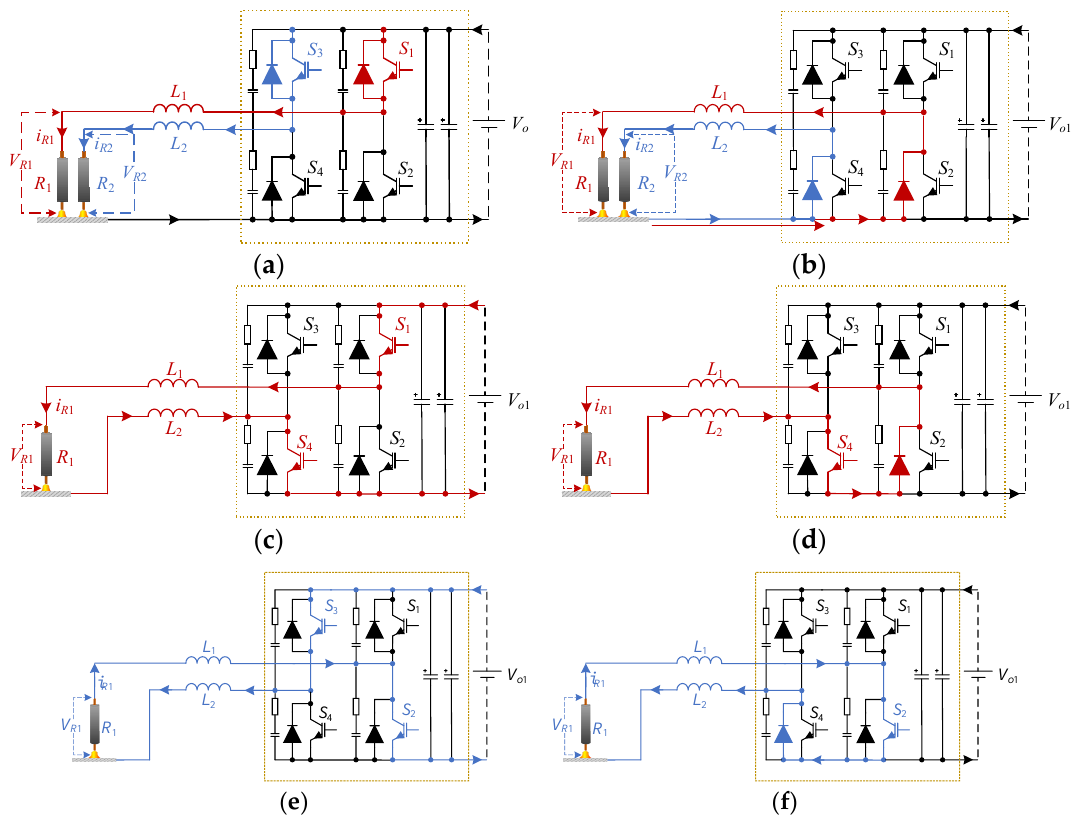
Figure 3. Different work modes. ( a ) IGBTs switch in DC mode ( b ) Continuous Current in DC mode; ( c ) IGBTs switch in AC forward mode ( d ) Continuous Current in AC forward mode; ( e ) IGBTs switch in AC reverse mode ( f ) Continuous Current in AC reverse mode.